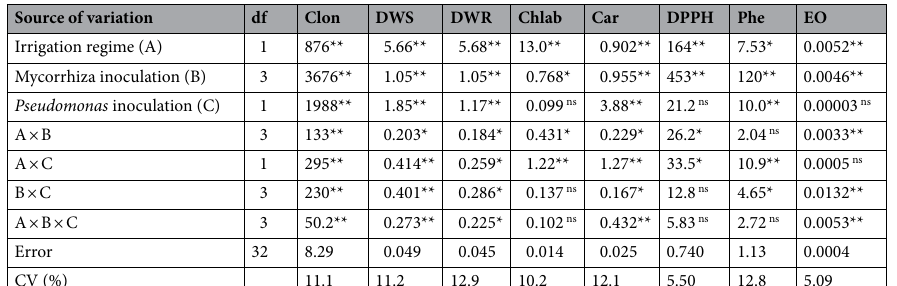
Table 2. Analysis of variance (including source of variation, degrees of freedom [df], mean square values, P values, and coefficient of variation [CV]) for root colonization (Clon), shoot dry weight (DWS), root dry weight (DWR), total chlorophyll (Chlab) content, carotenoids (Car) content, DPPH activity, total phenolic (Phe) content, and essential oil (EO) content of Arizona cypress seedlings inoculated with two arbuscular mycorrhizae ( Rhizophagus irregularis and Funneliformis mosseae ) and one rhizobacterium ( Pseudomonas fluorescens ) grown under two irrigation regimes. ns not significant. *Significant at the 5% probability level. **Significant at the 1% probability level.